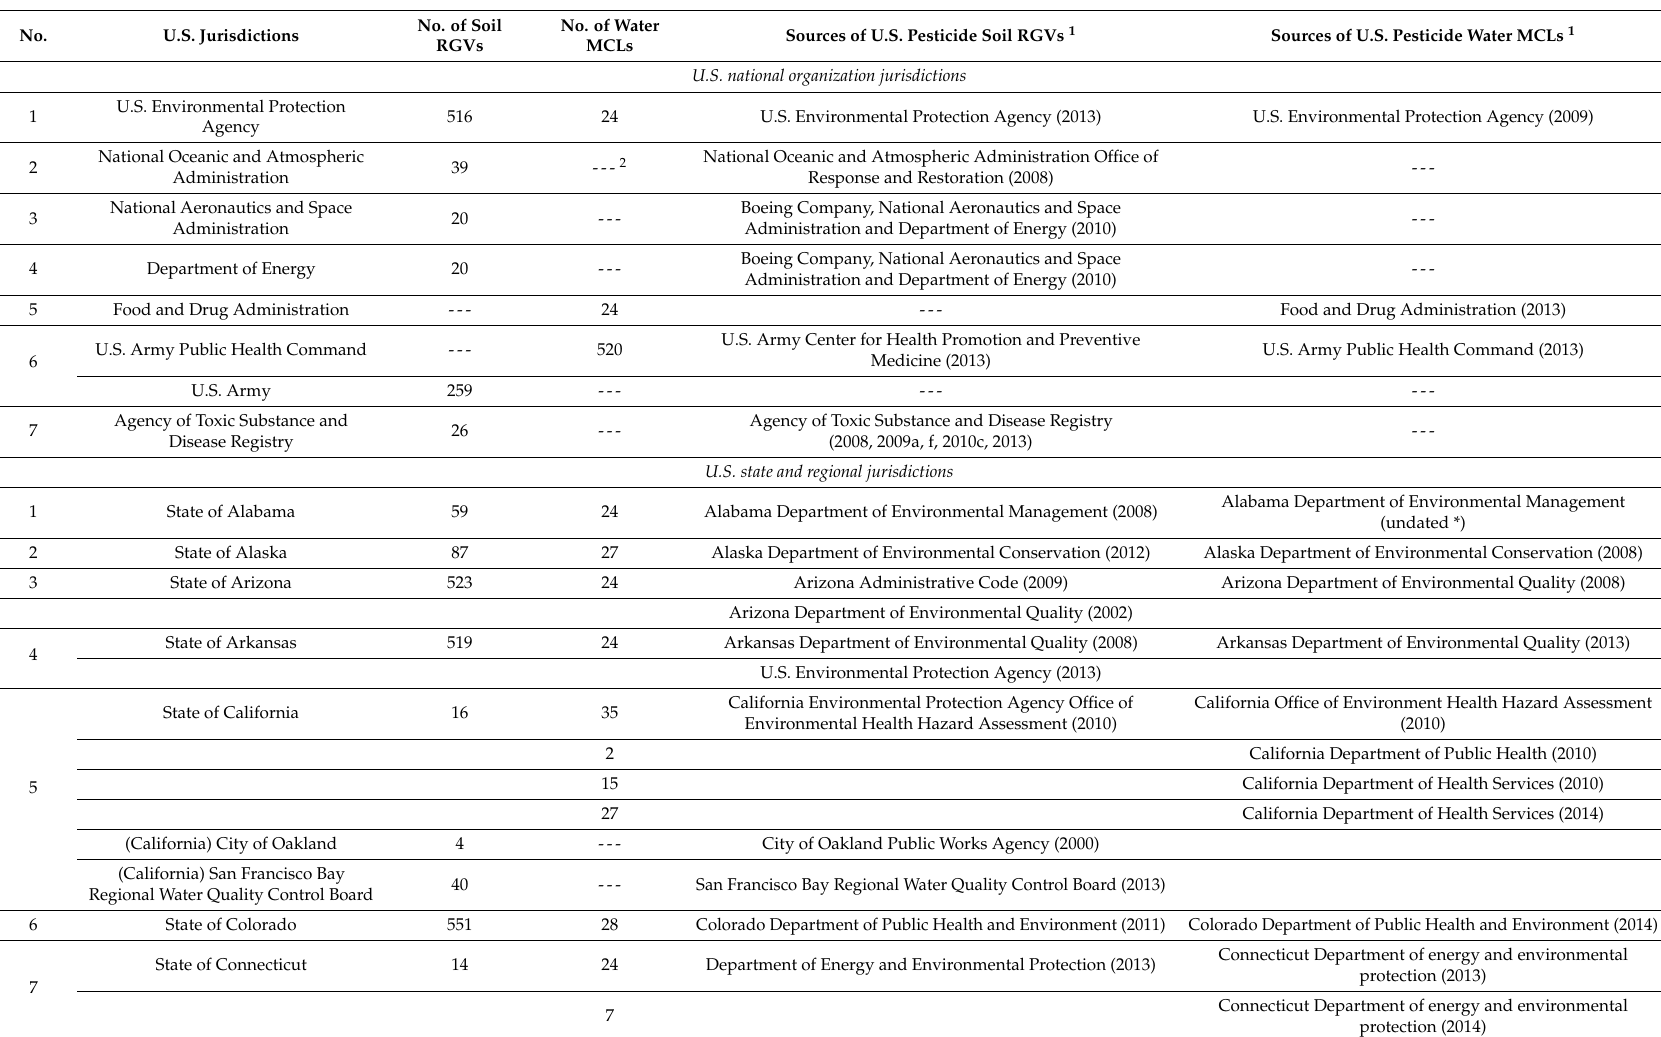
Table 2. U.S. pesticide RGVs and MCLs jurisdiction sources for state, regions, U.S. territories, and national